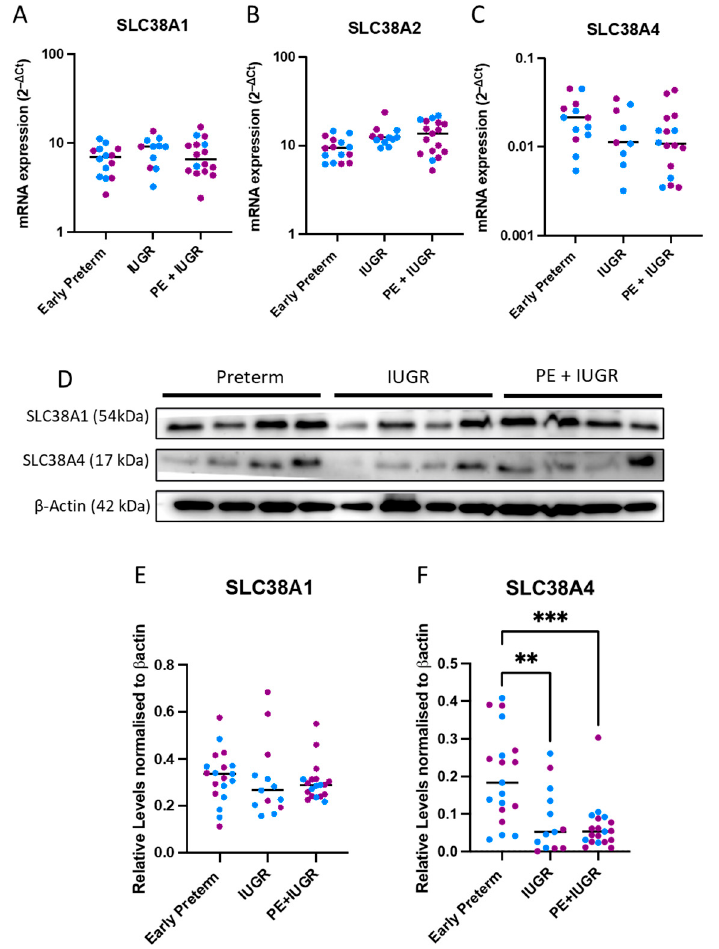
Figure 1. In early preterm gestation patients, SLC38A4 protein levels were significantly reduced in IUGR complicated placentas. In IUGR and PE + IUGR placentas, compared to preterm controls, mRNA expressions (assessed via qPCR) of SLC38A1 (A), SLC38A2 (B), and SLC38A4 (C) were not different. Western blots (D) showed that, at the protein level, SLC38A1 (E) was unchanged between groups. SLC38A4 (F) was significantly decreased in both IUGR and PE + IUGR cohorts (n = 11–19 samples/cohort). Results are displayed as medians. ** p < 0.01, *** p < 0.001 (Kruskal Wallis non-parametric test for qPCR results and Western blot analysis). Blue dots (male pregnancies), purple dots (female pregnancies).